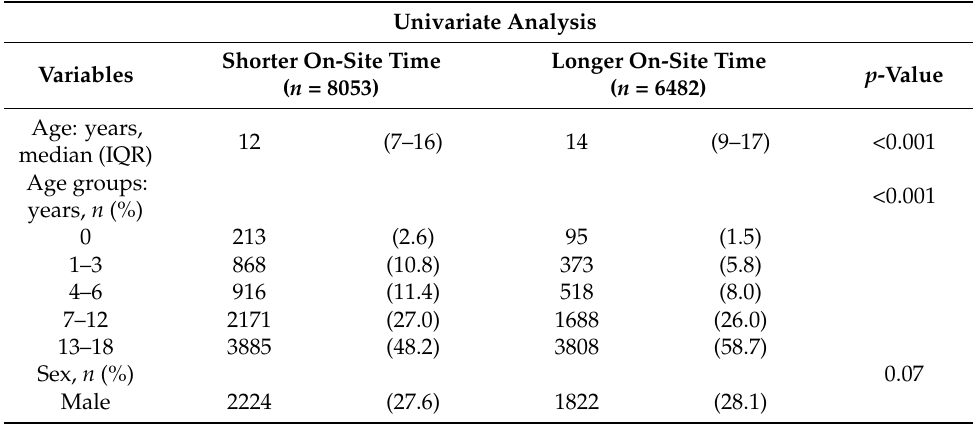
Table 2. Univariate analysis of factors associated with the length of on-site